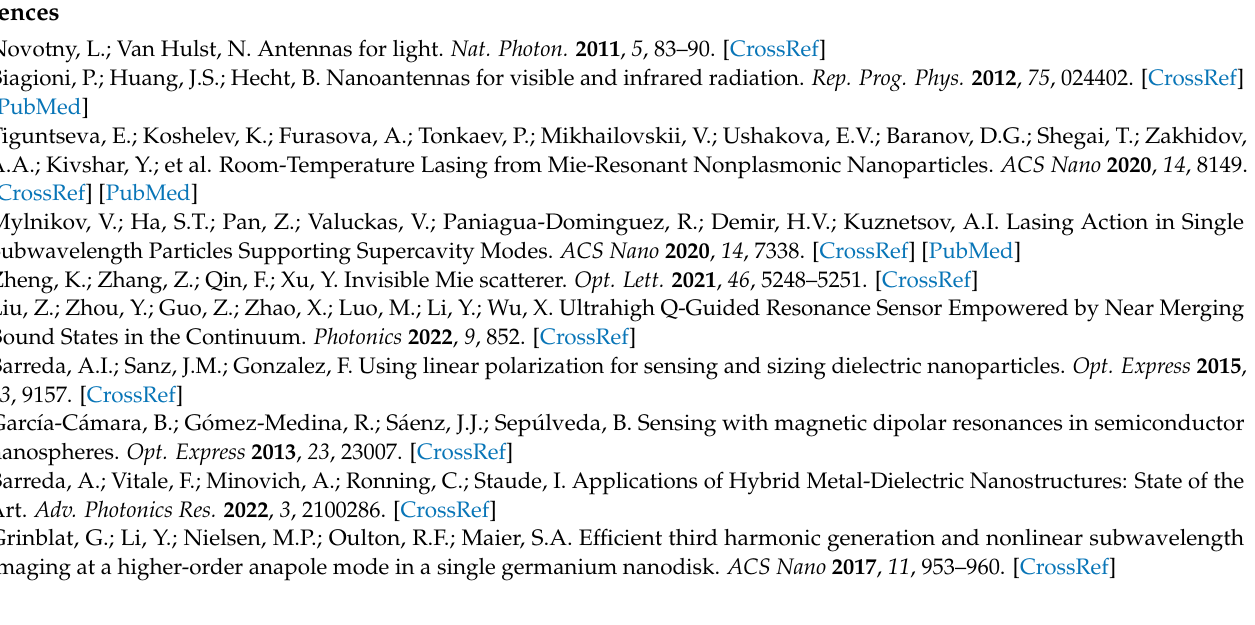
that differs from the dispersion Equation (A15) only by the absence of ε in the parenthesis.